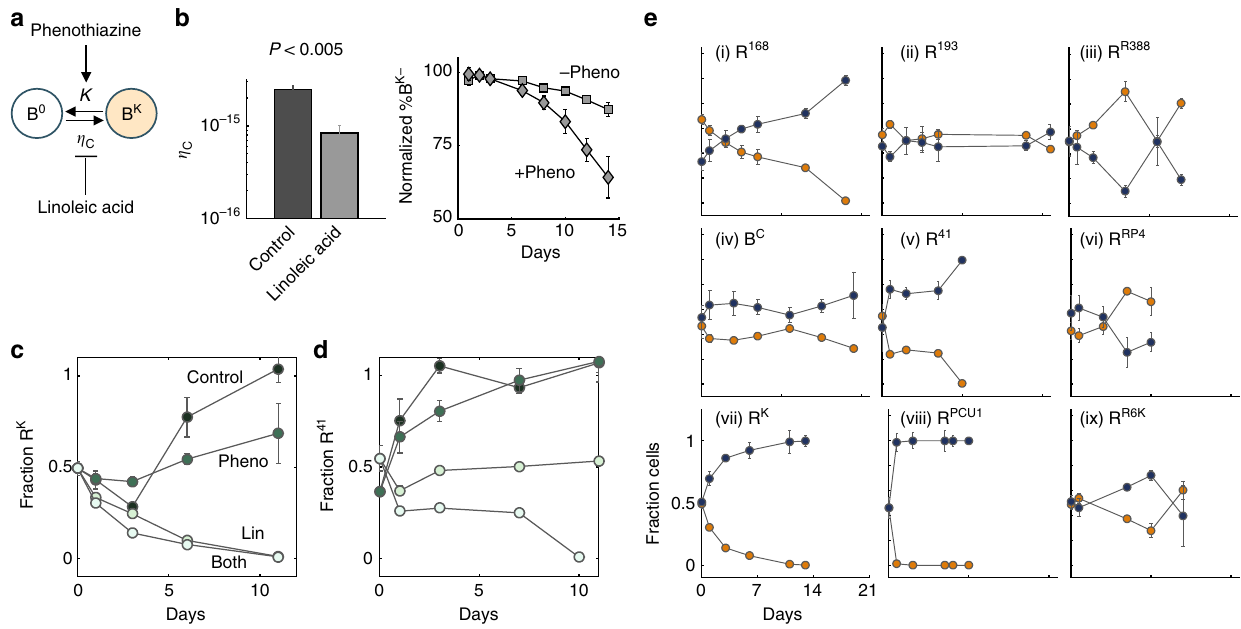
Fig. 4 Reversing resistance due to conjugation-assisted persistence. a Combining inhibition of conjugation and promotion of plasmid loss to reverse